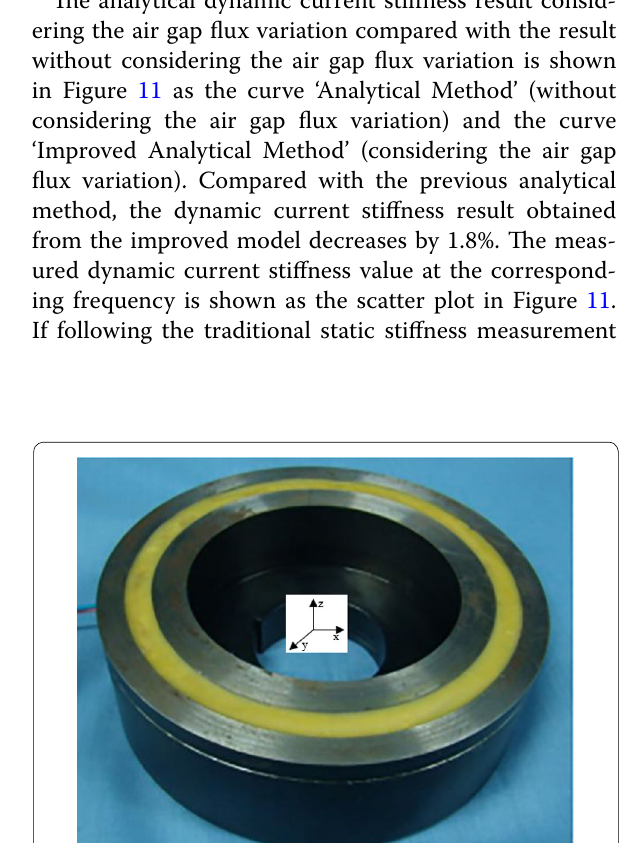
Figure 8 Flow diagram of dynamic stiffness measurement experiment